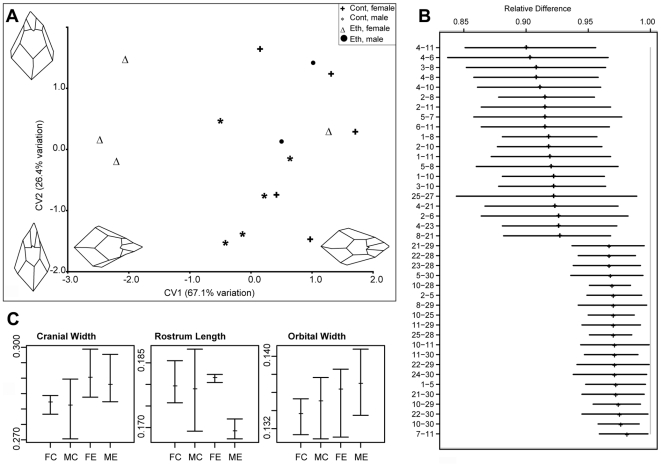
Quantitative analysis of the effects of gestational exposure to ethanol on skull shape.(A) Output of the CVA on the procrustes coordinates. Two components account for more than 90% of the total variation. CV1 clearly discriminates ethanol treated female specimens from the rest of the samples. Both male and female ethanol specimens have CV2 values close to (and above) 0, whereas controls span the entire range. Changes in the skull morphology were visualized by using the loadings of the first two canonical variates. Negative values of CV1 indicate a relatively wider skull and relatively longer rostrum. Positive values of CV2 indicates relatively wider orbits (as measured by landmarks 7–11), and shorter rostrum. (B) Output of the EDMA form difference matrix. Out of the possible 561 interlandmark distances, the top and bottom 20 are shown. Values are reported as the proportion of ethanols to controls for each interlandmark distance. None of the confidence intervals for the reported distances crosses 1.0, indicating that all the dimensions are significantly lower in the ethanol specimens. The higher values at the bottom of the graph indicate relatively expanded dimensions for ethanols. 90% confidence intervals were estimated by the non-parametric bootstrap method. For landmark descriptions and positions, see Text S1 and Figure S3. (C) Mean relative size of selected linear dimensions in ethanol and control groups. Tails indicate the observed range. Measurements are divided by the centroid size to remove the size effect. Cranial width is measured as the distance between landmarks 15 and 17; rostrum length is measured as the distance between landmark 9 and center of landmarks 1 and 2; orbital width is measured by the distance between landmark 7 and 11. Abbreviations: FC, female control; MC, male control; FE, female ethanol; ME, male ethanol. Goodall's F test was used to test for statistical significance of mean shape differences among groups.